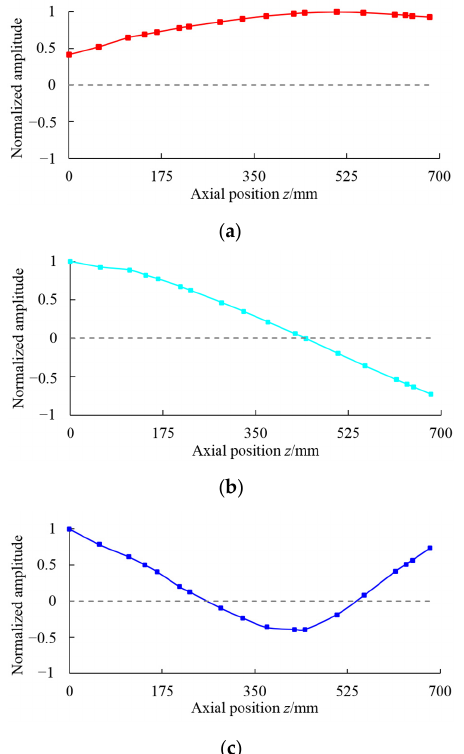
Figure 8. The first three-order mode shapes. ( a ) First order. ( b ) Second order. ( c ) Third order.